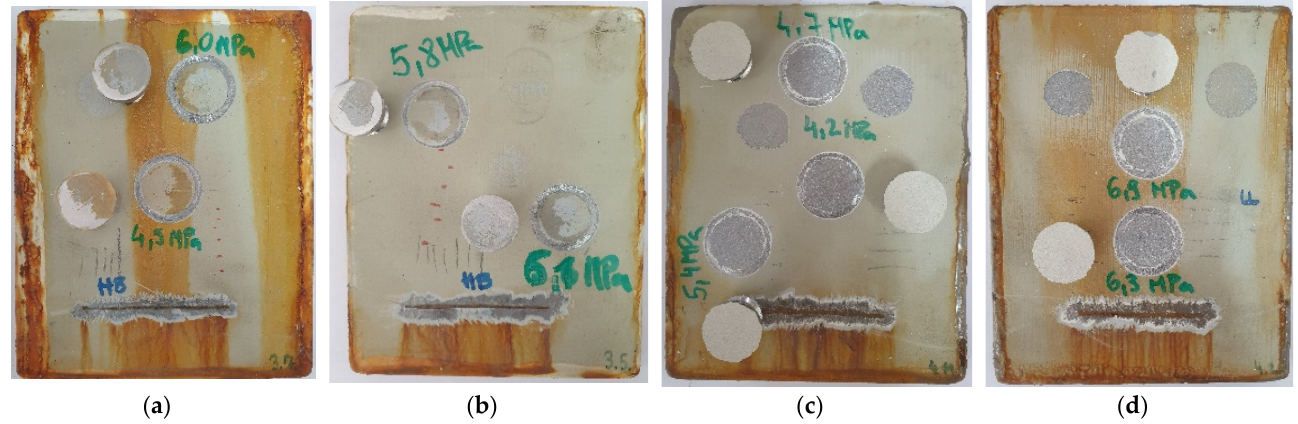
( b ) Figure 2. Coating systems with ( a ) and without ( b ) zinc in the primer after 720 h exposure in salt spray chamber according to ISO 9227. Assessment of the coating’s corrosion or stability tendency in sodium chloride solu ‐ tion was conducted through OCP measurement [14]. A saturated calomel electrode acted as a reference electrode [14] in 3% NaCl solution, at room temperature 23 ± 2 °C, against which the open circuit potential of the coating was measured. The duration of OCP meas ‐